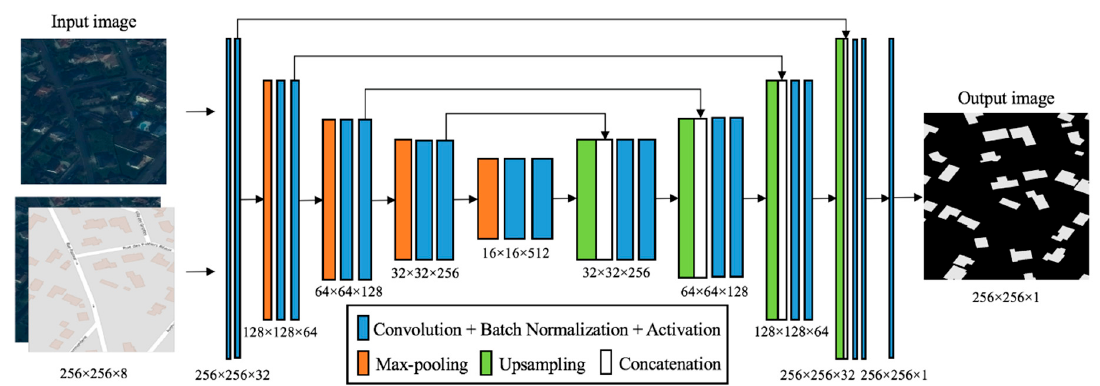
Figure 3. Architecture of semantic segmentation model for building extraction.